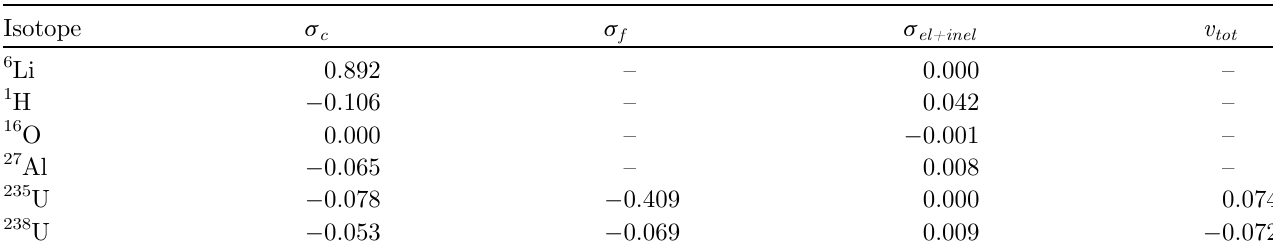
for the MAESTRO thermal-spectrum experiment. Li